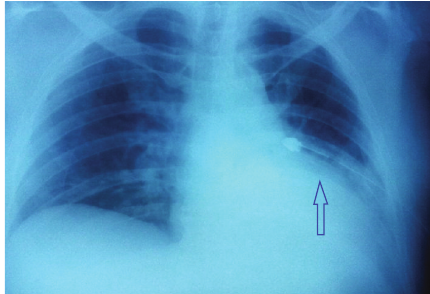
Figure 3: Chest X-ray after insertion of chest